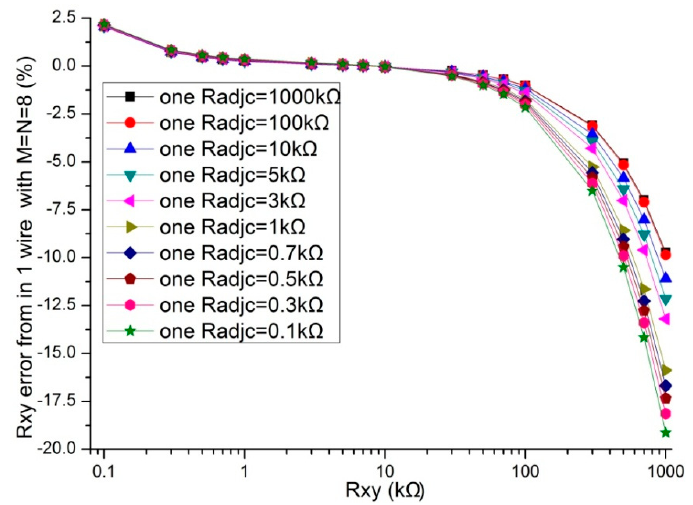
Figure 4. The R adjc effect on R xy errors in the one-wire VF-NSDE circuit.